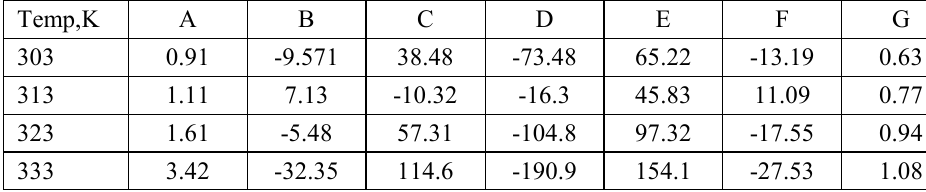
Table 5. Effect of the sodium pseudo cumene sulfonate.